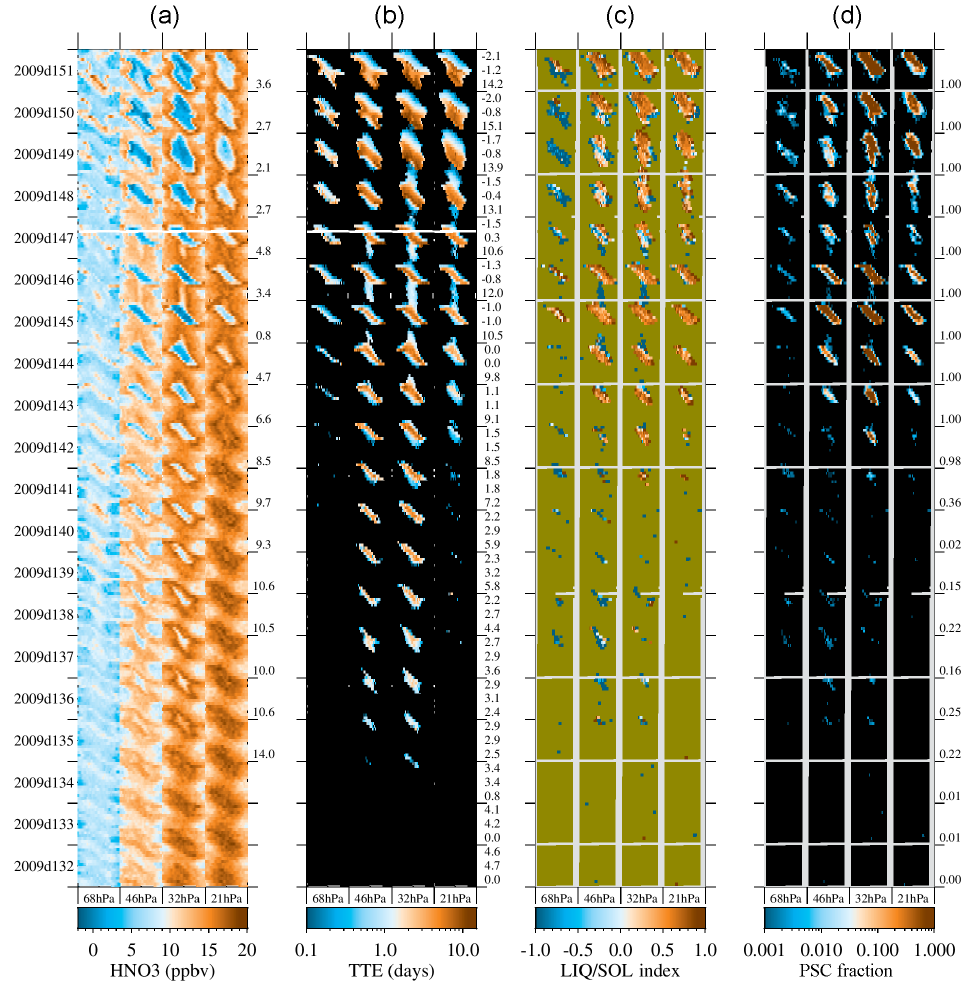
Figure 11. Twenty-day time series of Antarctic raster plots at 68, 46, 32, and 21hPa in 2009 from day number 132 (12 May) to 151 (31 May). Gray shading indicates no observations; olive-green shading indicates observations but no detections. (a) MLS HNO 3 . Numbers on the right axis indicate the median HNO 3 for the region where TTE > 2 days (in ppbv) for each day at 32hPa. (b) Temperature history. A set of three numbers on the right axis for each day at 32hPa indicates in ascending order (i) maximum TTE in days, (ii) minimum local temperature, T − T ICE in K, (iii) minimum temperature encountered along the back-trajectory, and T − T ICE in K. (c) CALIOP LS_index . (d) CALIOP PSC fraction. Numbers on the right axis indicate the maximum PSC fraction (ratio of the number of PSC detections to the number of observations) for each day at